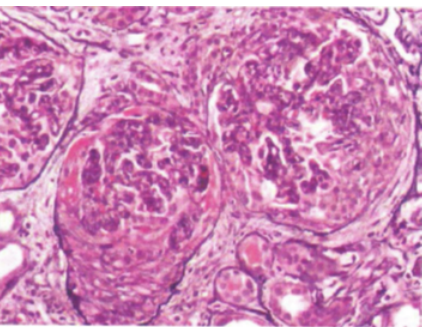
Figure 1: Light micrograph of crescentic glomerulonephritis with fibrinoid necrosis, showing mild mesangial expansion and min- imal increase in cellularity without endocapillary proliferation. Subepithelial spikes were noted on the silver stain.